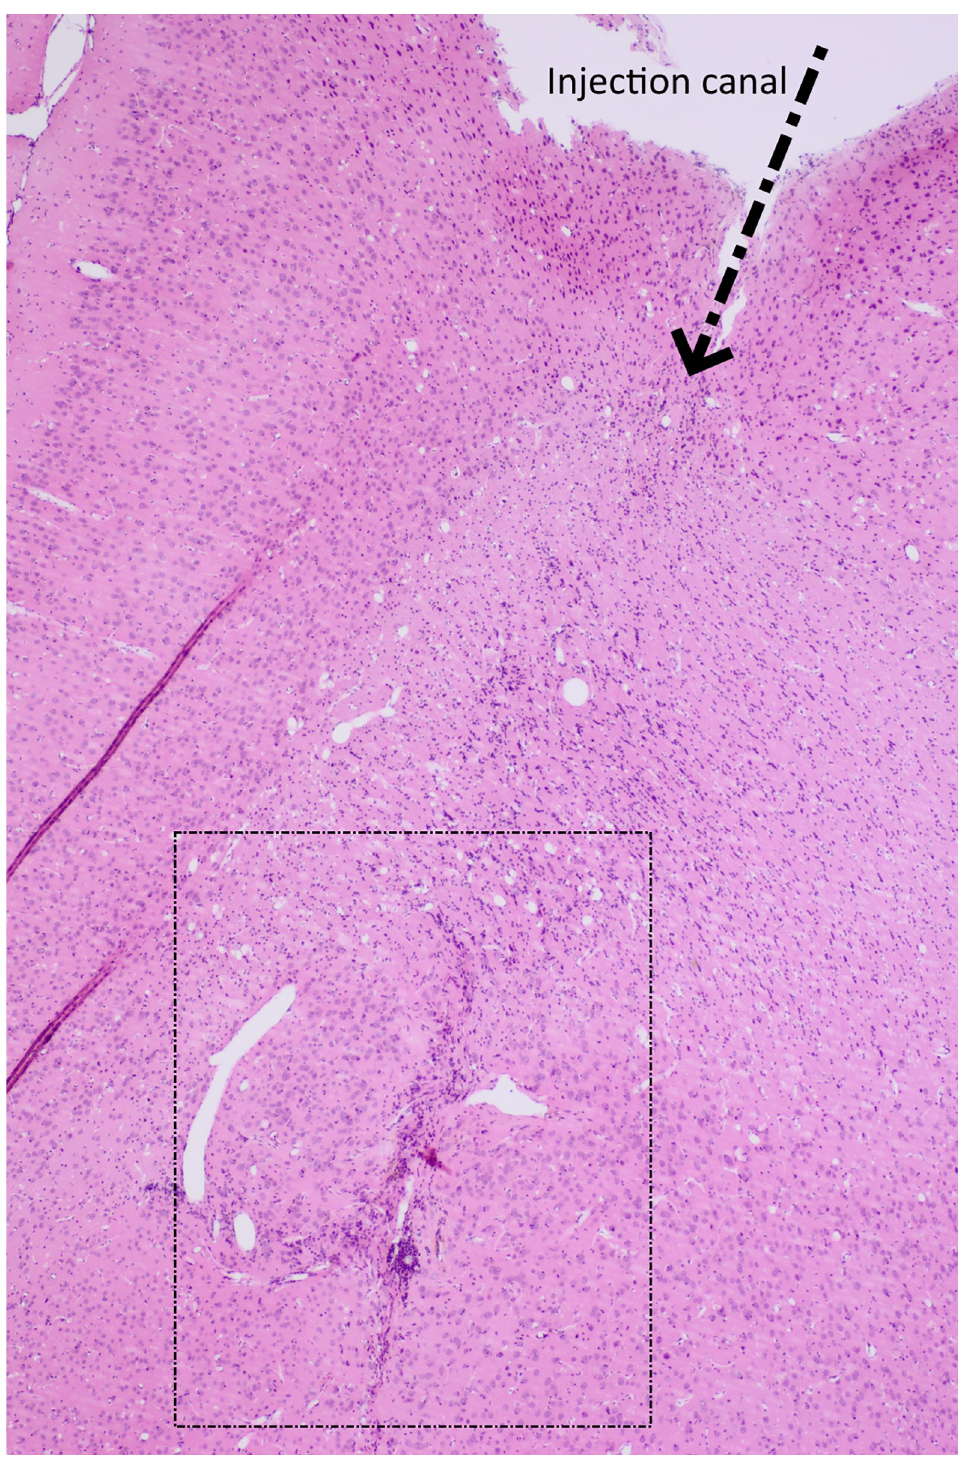
Fig 8. Htx and eosin stained section of the tumor site of one animal surviving for 100 days after tumor inoculation. The animal was treated with 1-MT and 2 fractions of 8 Gy irradiation separated by 7 days.